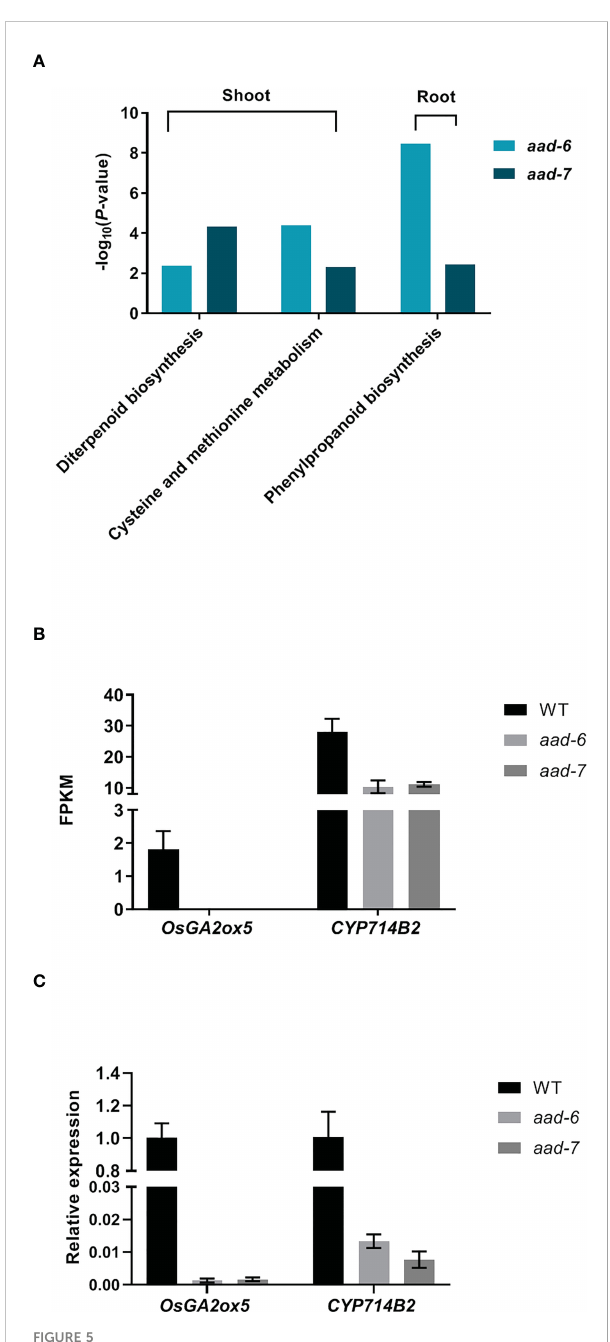
FIGURE 5 Transcriptome analysis of shoots and roots in two lines of aad mutants under low-Pi treatment for 2 weeks. (A) Histogram of the Kyoto Encyclopedia of Genes and Genomes (KEGG) pathway enrichment results. The X-axis is the name of the pathways, and the Y-axis is -log 10 ( p -value) enriched by each pathway. (B) and (C) FPKM and relative expression level of two genes related with GA pathway in shoots of two aad mutants and WT, respectively. Values represent means ± SD of three biological